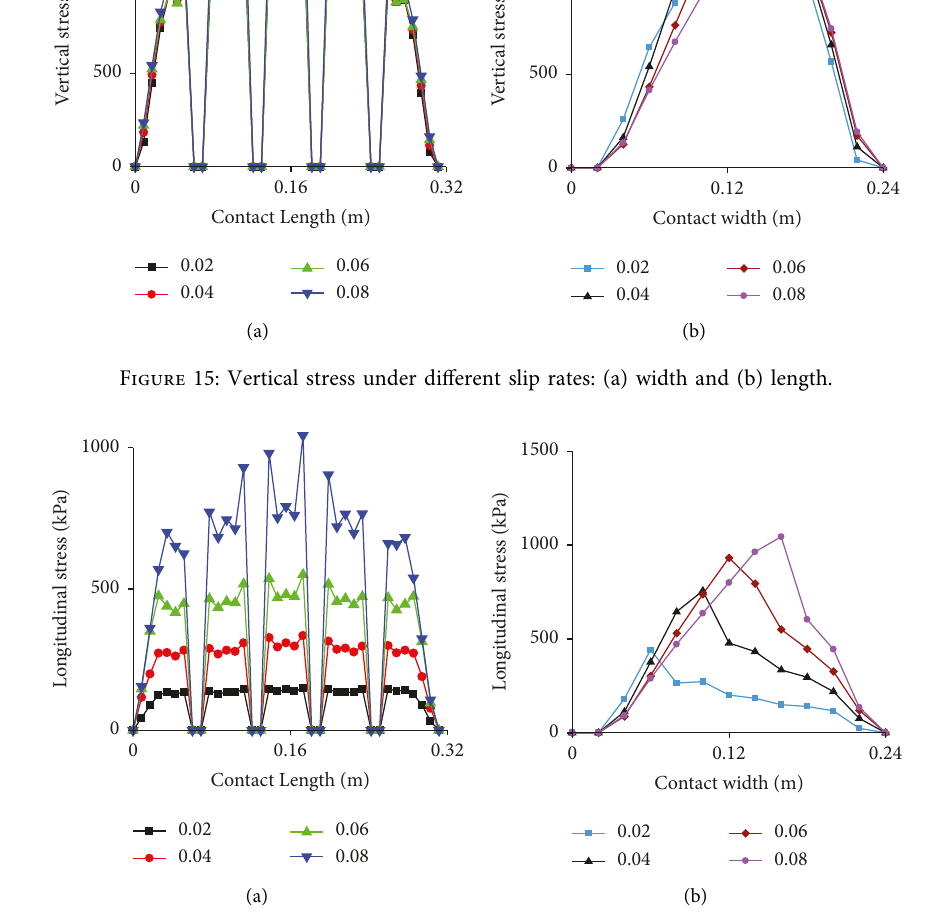
Figure 16: Longitudinal stress under different slip rates: (a) width and (b)